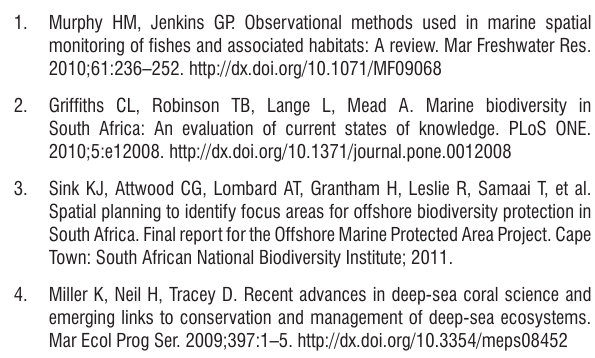
Common name (total number of species recorded with all six methods) Jawless fishes (1 species) Cartilaginous fishes (7